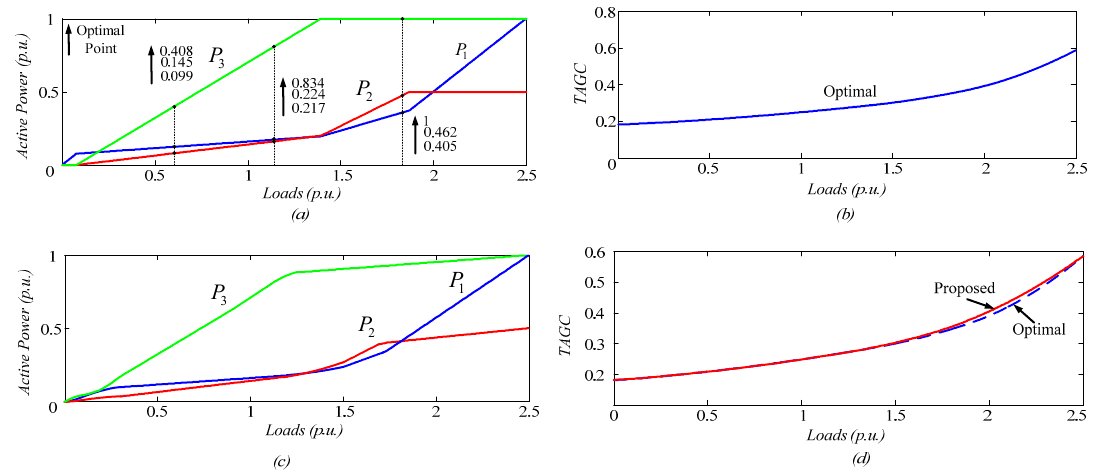
Figure 10. Power allocation results ( a ) power allocation among DGs through the interior point method; ( b ) total active generation cost (TAGC) of the interior point method; ( c ) power allocation among DGs through the proposed droop control scheme; ( d ) TAGC of the proposed droop control